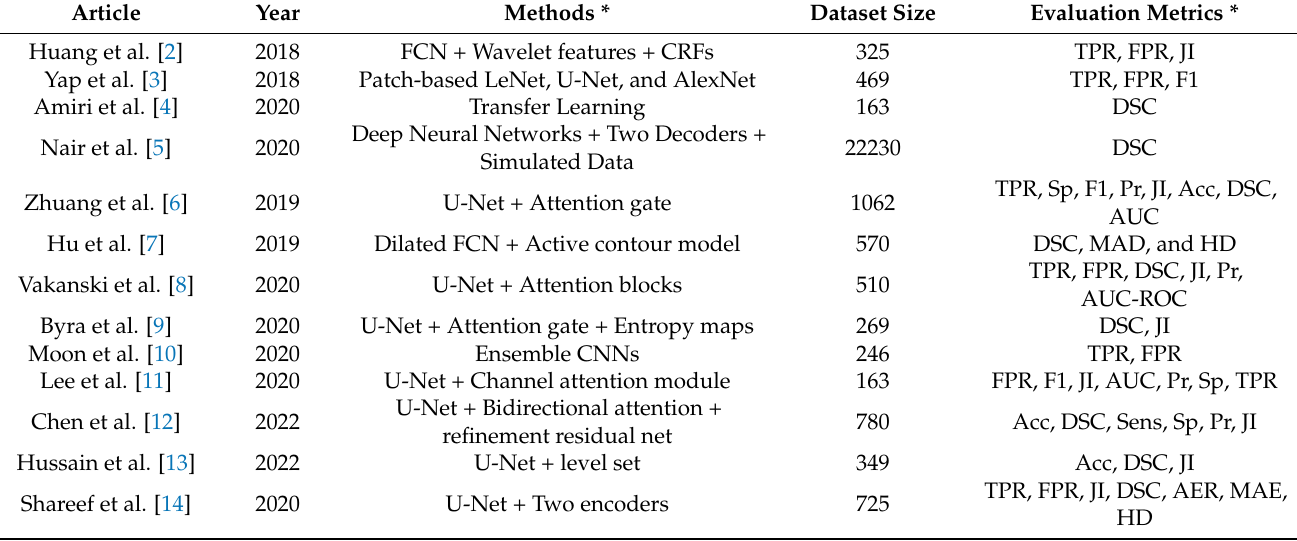
Table 1. Deep learning approaches for BUS image